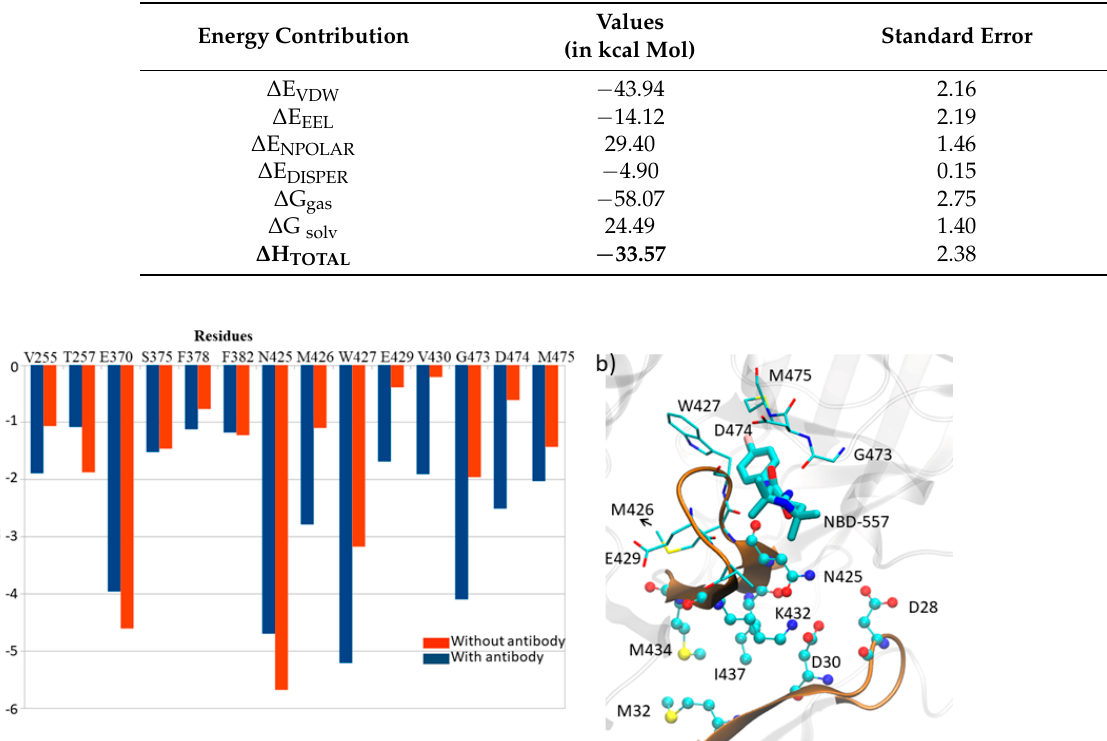
Table 4. The thermodynamical parameters for NBD-557 when binding with gp120 in the presence of antibody. All abbreviations have the same meaning as defined in Table 1 .